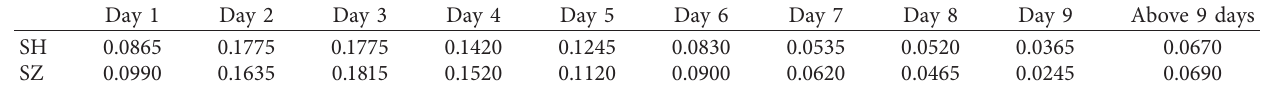
Table 5: Frequencies of the second extreme jump occurrence on following days.